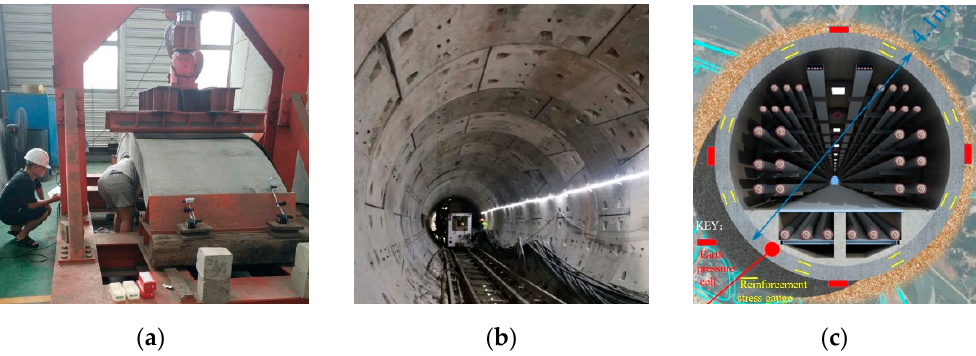
Figure 11. Field segment data measurement. (The earth pressure cells and reinforcement stress gauges are embedded in the segment. The axial force and bending moment of the segment are derived from the measured data of the reinforcement stress gauges, and the measured internal force of the segment is obtained, which is shown in Table 2.) ( a ) Indoor data measurement. ( b ) Field data measurement. ( c ) Diagram of layout of measuring points.